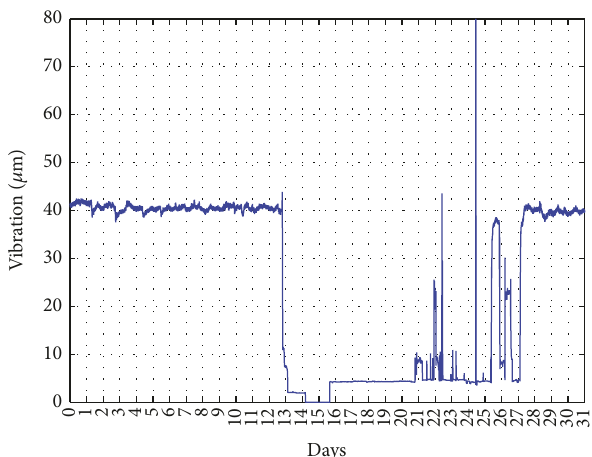
Figure 2: [CS1] Plot of load (%) versus time (days): identification of clustersinpower/loadmeasurements(month1—normaloperation).